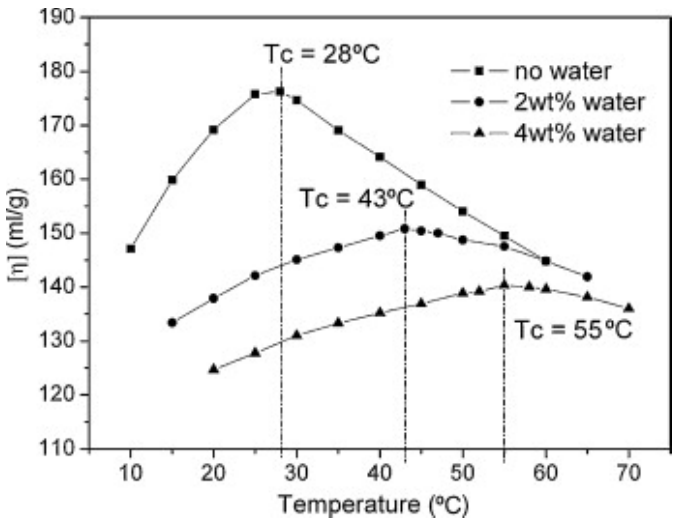
Figure 5. Temperature dependence of the intrinsic viscosity ( η ) for 23 wt% PAN/dimethyl sulfoxide (DMSO) solution at different water contents (reprinted with permission from [60] , copyright 2009 Elsevier).